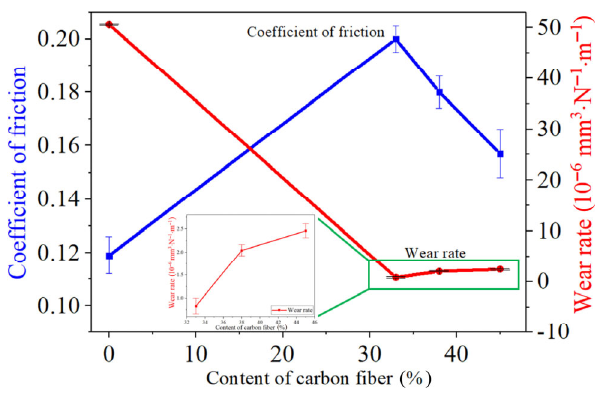
Fig. 5 COF and wear rate of LAS and C f /LAS composites with different carbon fiber